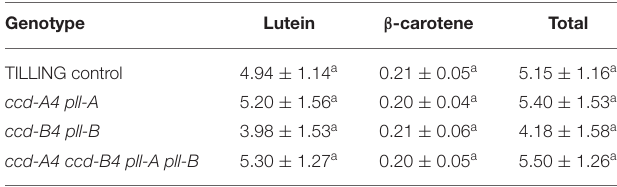
TABLE 2 | Carotenoids (nmol g − 1 flour) in mature whole grains of TILLING control and mutant plants.